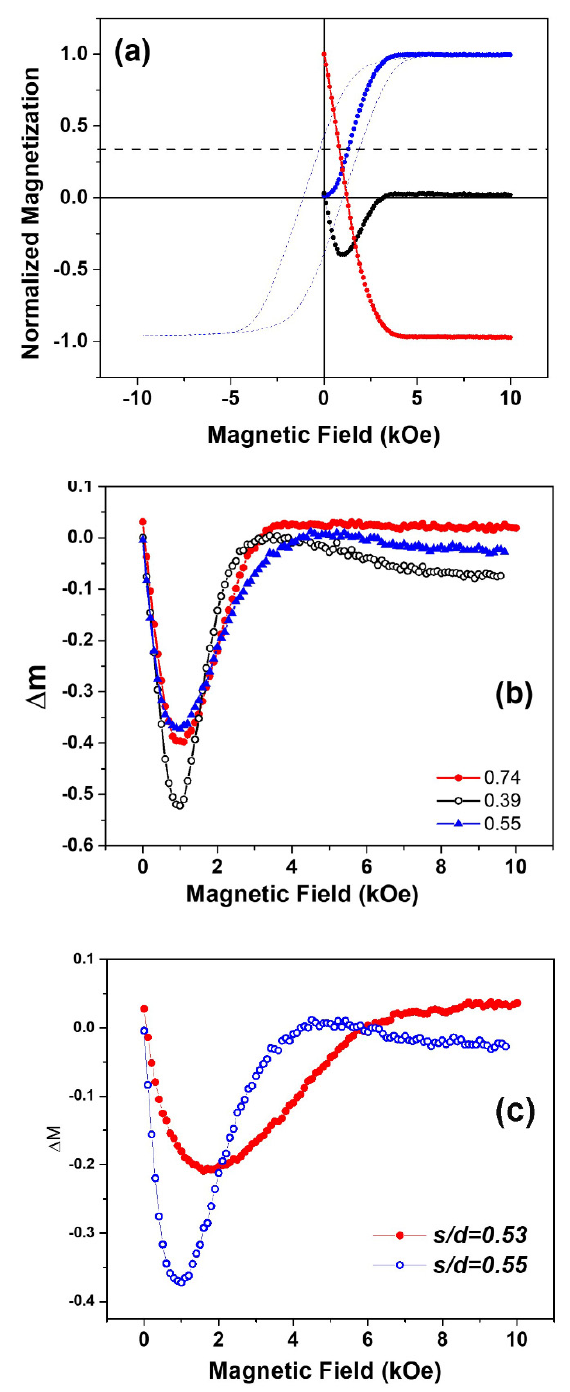
Figure 5. ( a ) IRM and DCD remanence curves, m r (blue) and m d (red), respectively, along with the major hysteresis loop (dotted red) and calculated ∆ m curve (black) for the nanowires sample with s/d major hysteresis loop (dotted red) and calculated Δ m curve (black) for the nanowires sample with = 0.61 magnetic packing density 10.2%. ( b ) the ∆ m curves with different spacing-to-diameter ratios, s/d = 0.61 magnetic packing density 10.2%. ( b ) the Δ m curves with different spacing-to-diameter as mentioned. ( c ) ∆ m curves of the same s/d ratios and packing density but different ratios, as mentioned. ( c ) Δ m curves of the same s/d ratios and packing density but different diame- ters.